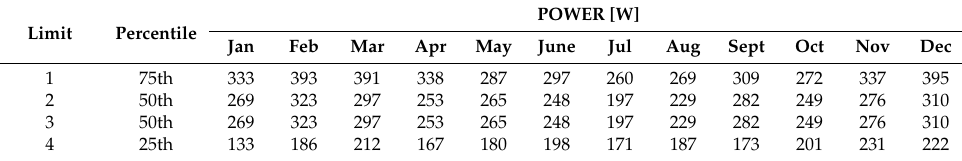
Table A6. Power thresholds limit for calculations over the Saturdays.